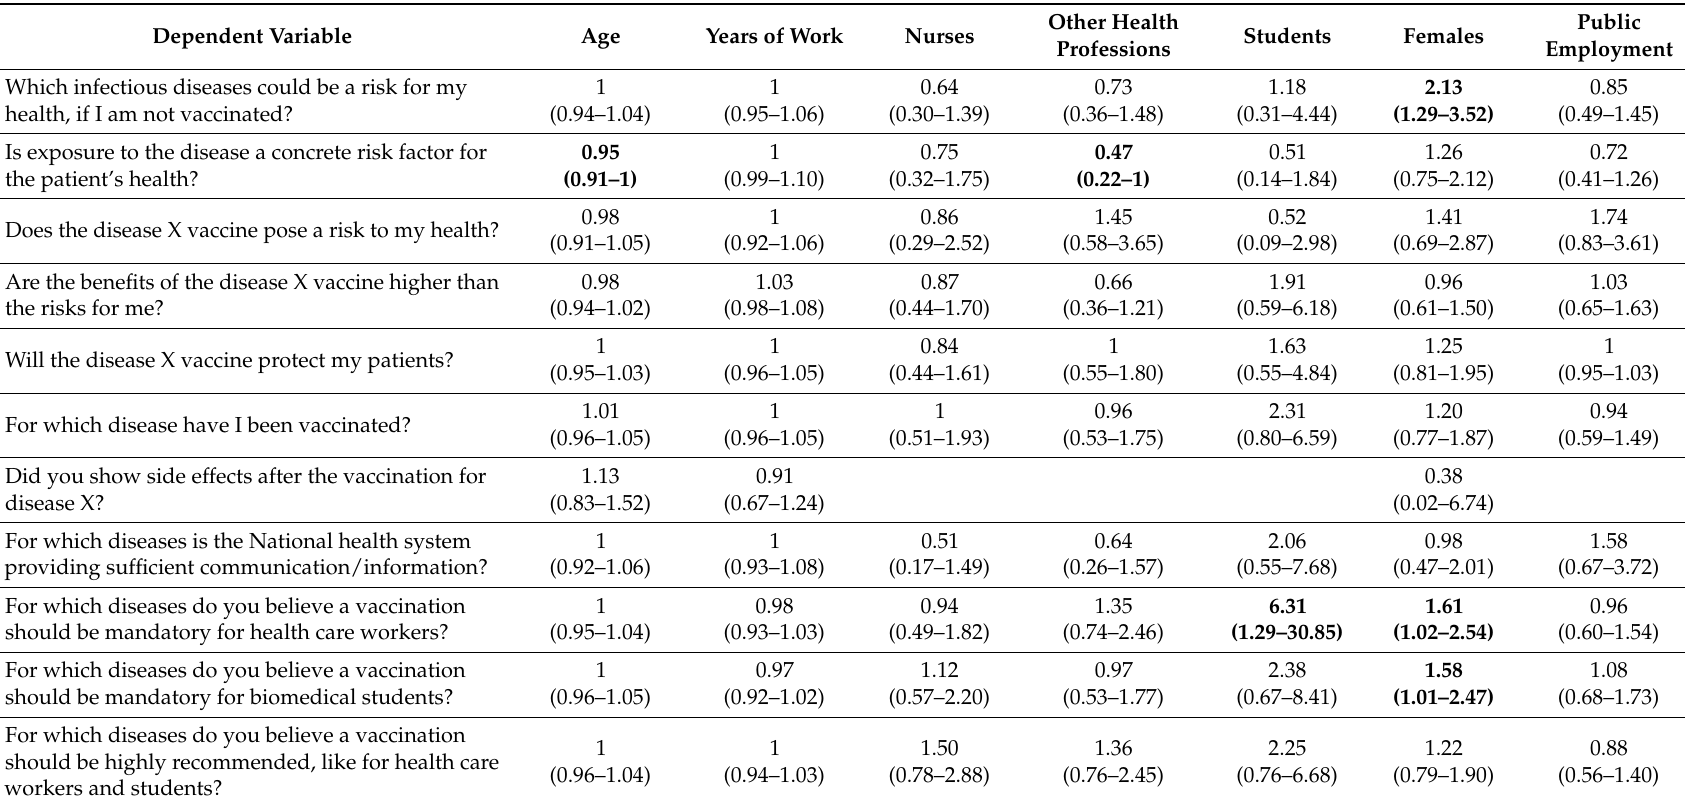
Table 3. Results of the multivariate analysis considering